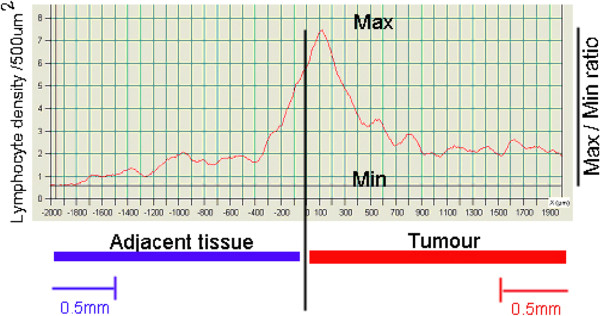
The ratio of the maximal and minimal CD3+ cells density was evaluated for all tumors. The variation was significantly lower when evaluated more than 1.5 mm away from the tumor invasive front.